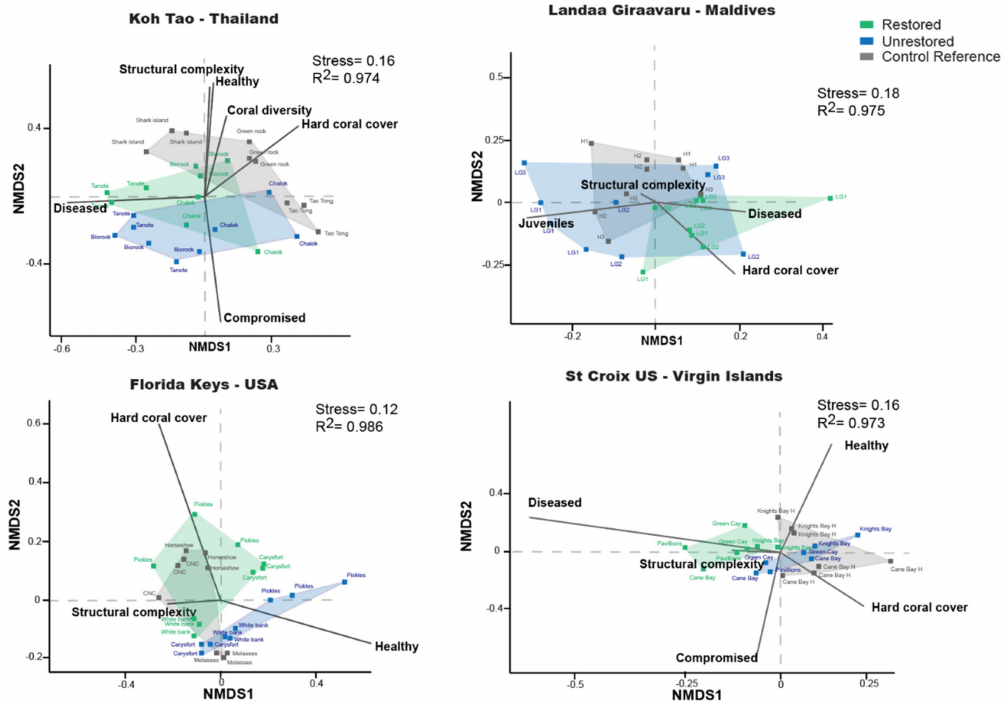
Figure 9. E ff ect of coral restoration on the composition of coral assemblages at four geographic locations, as represented by non-metric multidimensional scaling. Polygons represent coral assemblages in each treatment, where green polygons encompass restored sites, blue polygons encompass unrestored sites, and grey polygons encompass control reference sites. Colored shading reflects the location of the respective set of sites in non-metric multi-dimensional scaling space. Vectors represent the influence of benthic attributes on the benthic community composition.